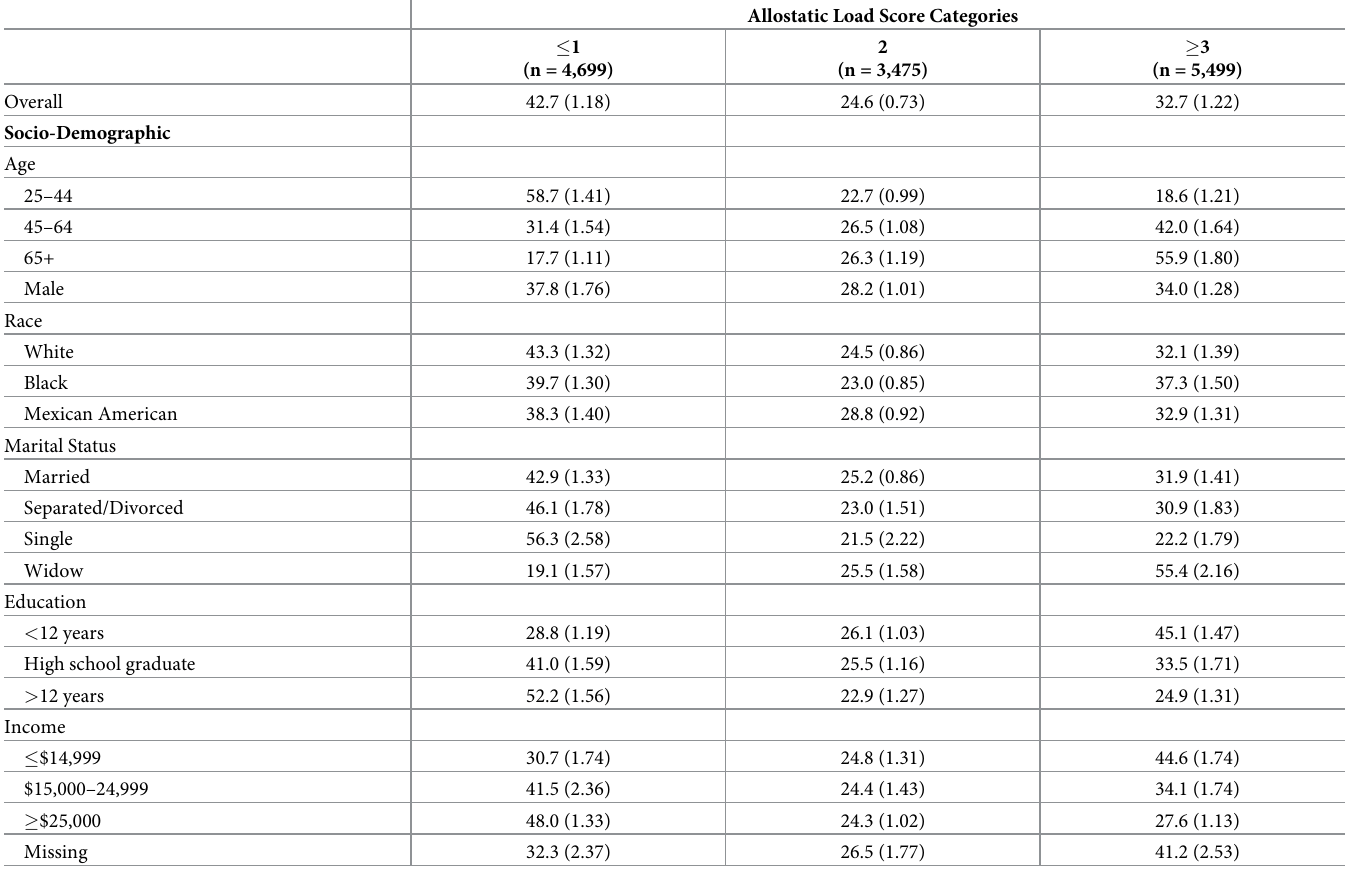
Table 2. Prevalence a of allostatic load according to selected socio-demographic and health-related characteristics for adults 25 years of age or older: NHANES III-- Linked Mortality File,